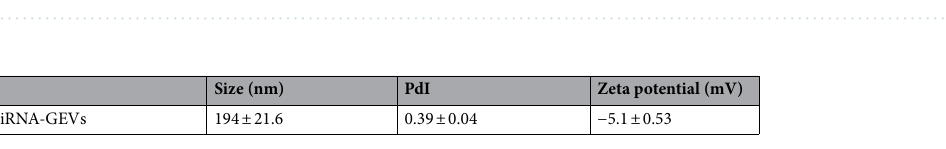
Table 2. Optimal values of causal factors predicted using the response surface method (optimal solutions were calculated based on the bootstrap resampling with replacement at 1,000, 2,000, 3,000, 4,000, and 5,000 times).